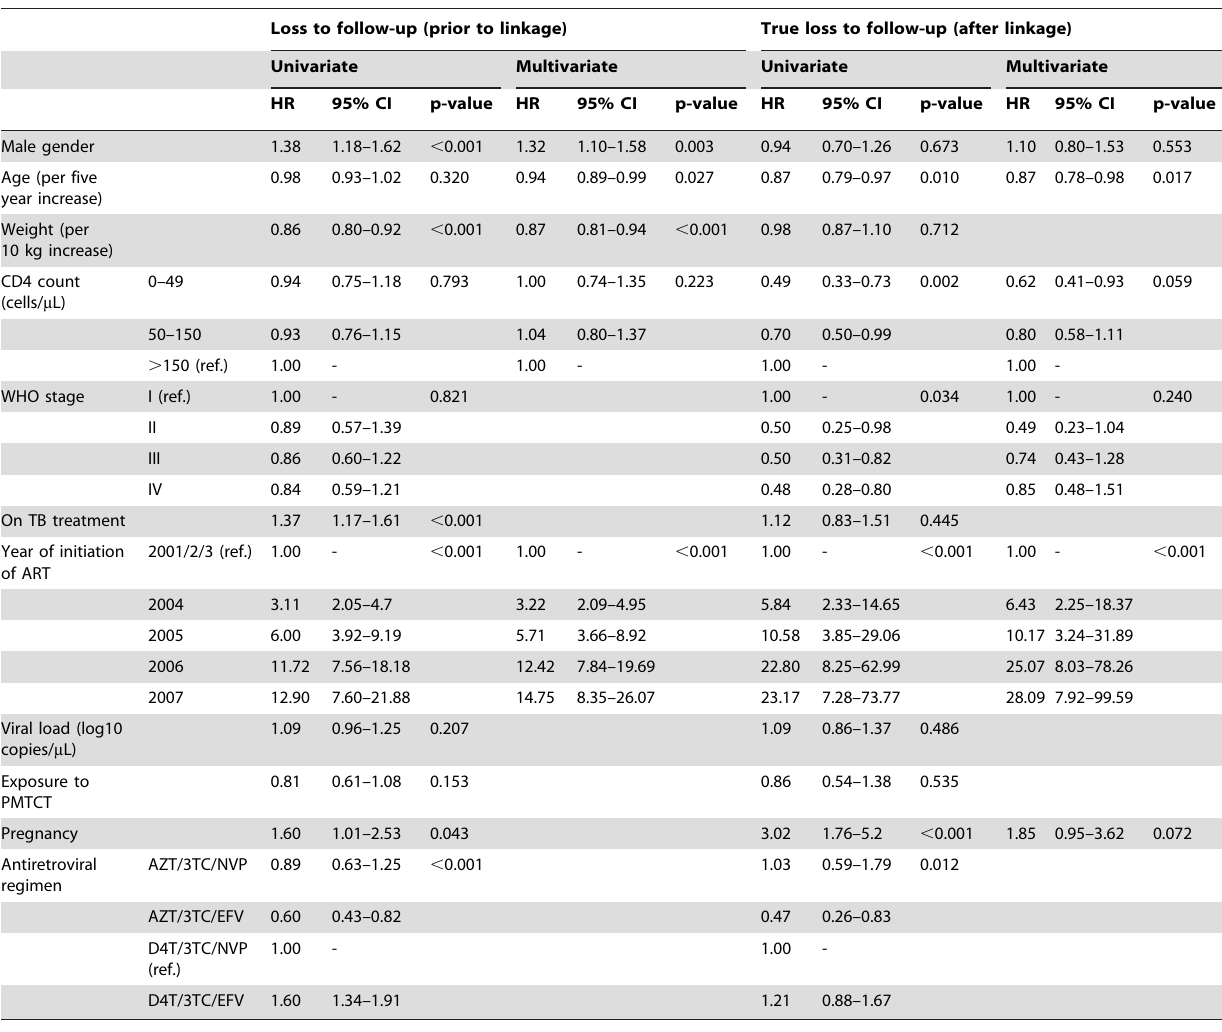
Table 2. Cox proportional hazards models of factors associated with loss to follow-up before and after correction for mortality.